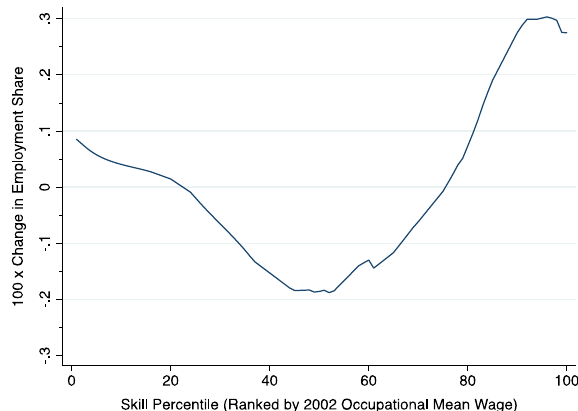
Fig. 2 Smoothed changes in Employment by wage percentile (1994, 2014). Notes the figure plots log changesinemploymentshareby2002jobskillpercentilerankusingalocallyweightedsmoothingregression (bandwidth 0.75 with 100 observations), where skill percentiles are measured as the employment-weighted percentile rank of a job’s mean log wage in the 2002 ESS. Sources : author’s analysis from the Spanish Labour Force Survey (1994, 2014), and the Structure of Earnings Survey